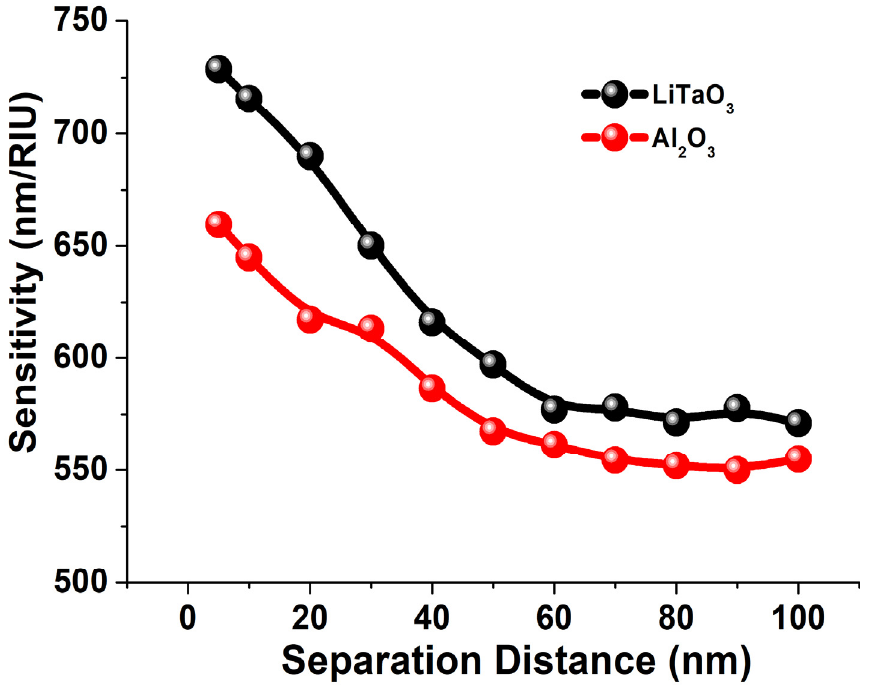
Figure 6. Sensitivity comparison of 10 layered stacked antenna array (5 gold layers with h 1 = 10 nm gold and 5 LiTaO 3 /Al 2 O 3 layers with a =100 nm, b = 10 nm and h 2 (LiTaO 3 and Al 2 O 3 ) = 10 nm) with respect to separation distance.